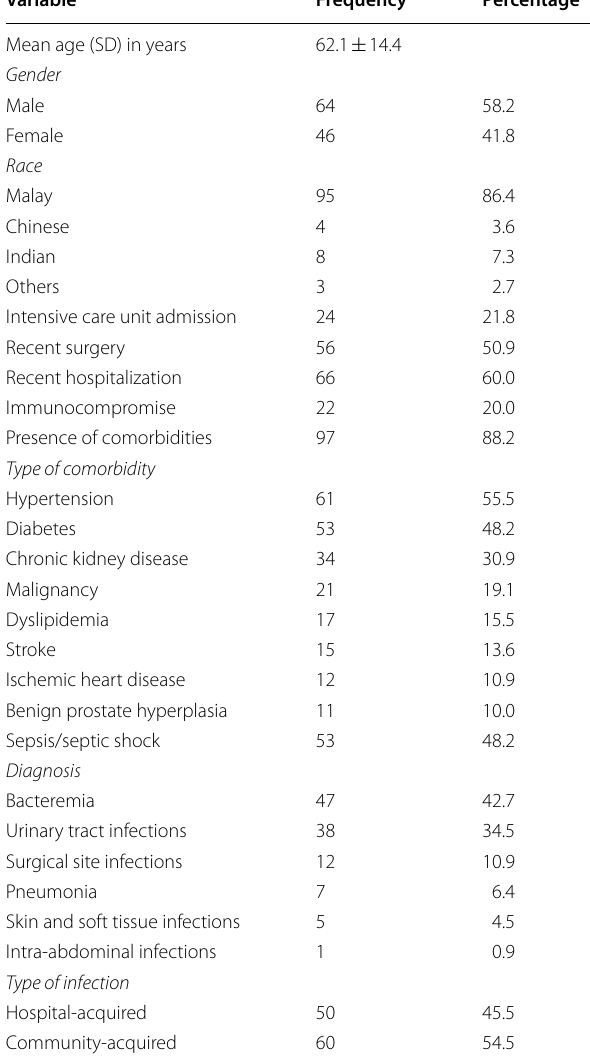
Table 1 Demographic and clinical characteristics of the